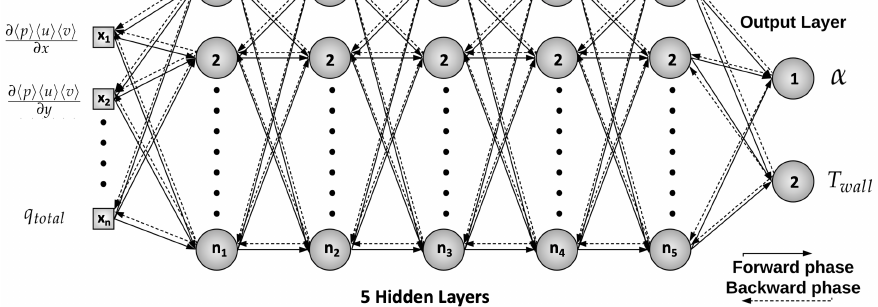
Figure 3. Back propagation deep neural network (DNN) architecture used in this